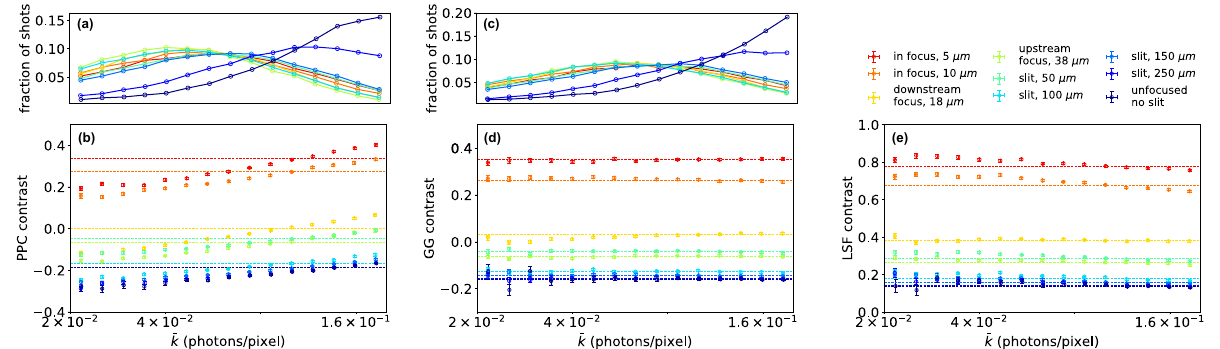
Figure 2. Contrasts extraction using the three algorithms of the same scattering data set. The dashed lines show the extracted overall effective contrast β e . ( a ) Extracted ¯ k distribution using the PPC method. ( b ) Extracted contrasts using the PPC method. ( c ) Extracted ¯ k distribution using the GG/LSF method. ( d ) Extracted contrasts using the GG method. ( e ) Extracted contrasts using the LSF method. The legend on top of ( e ) is shared by all the plots in this figure, and it explains the measurement conditions followed by the effective beam sizes on the sample. The error bars in ( b , d , e ) were estimated from photon counting